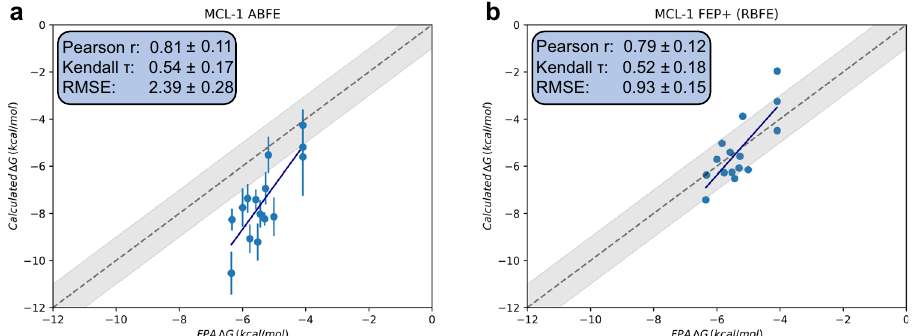
Fig. 7 Comparison of a subset of the MCL-1 dataset. a ABFE simulations and b the 2015 FEP + study by ref. 26 Free energy estimates are the means of the estimates across replicas, with error bars as their standard deviation. Correlation metrics calculated from the mean estimate values, with error bars derived from bootstrap resampling. All free energy results, including RMSE values, have units of